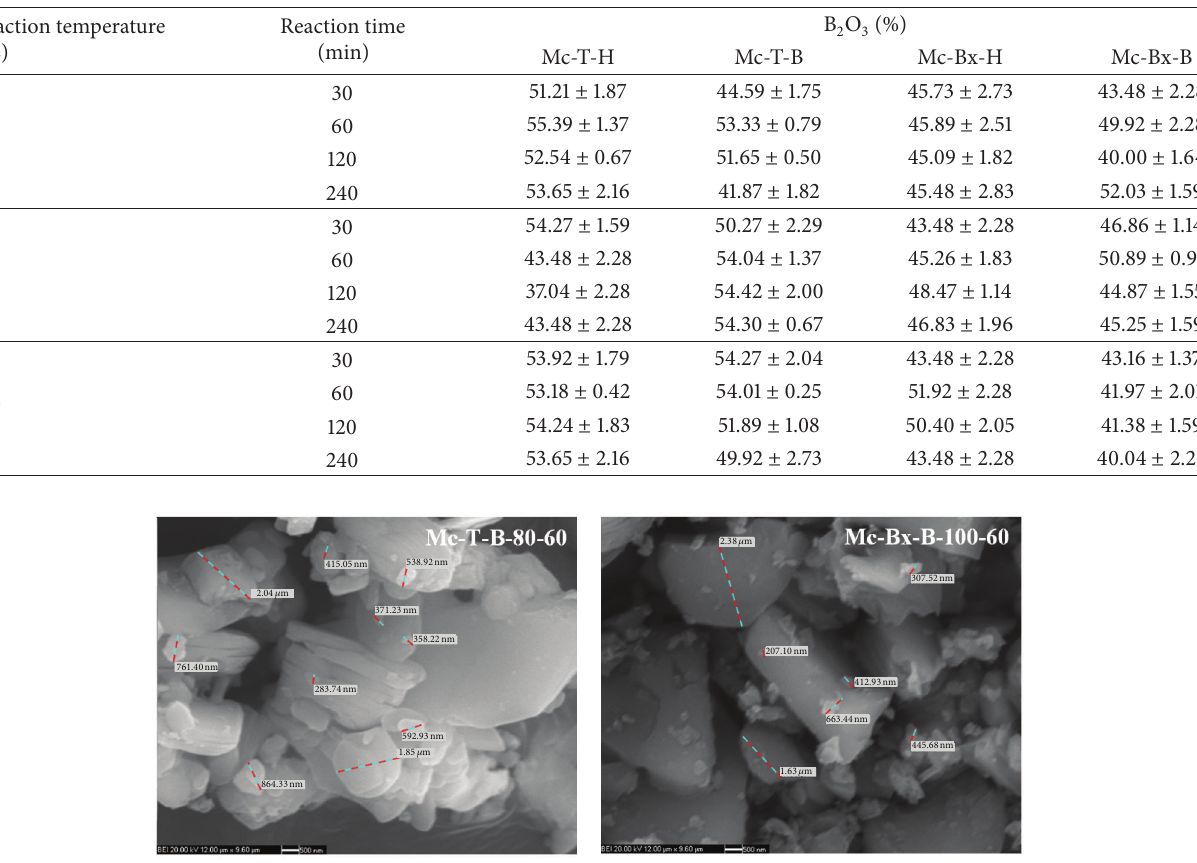
Table 3: B O contents of the synthesized magnesium borate minerals. 2 3